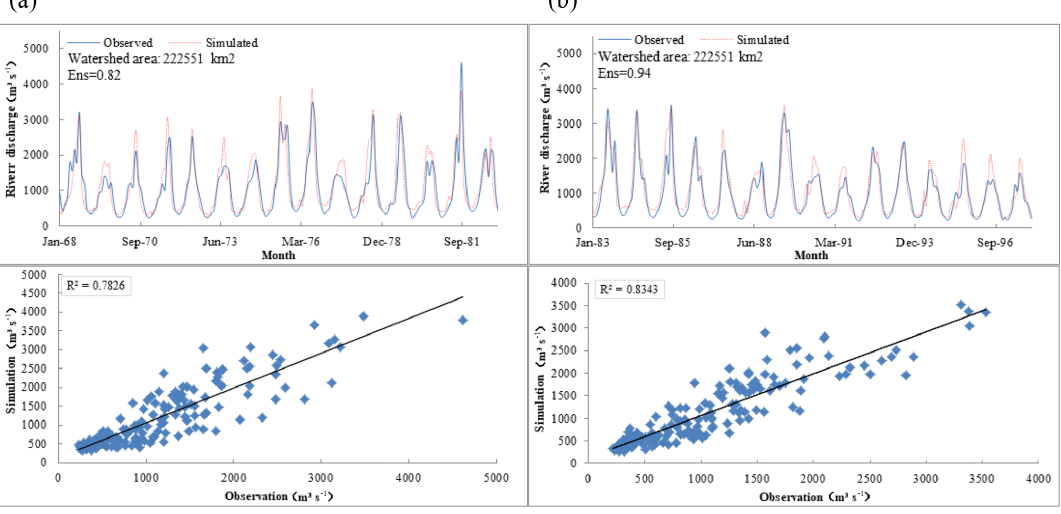
Figure 4. Comparison between the measured and the simulated discharges for Lanzhou hydrometric station. Calibration (a) and Validation (b) are